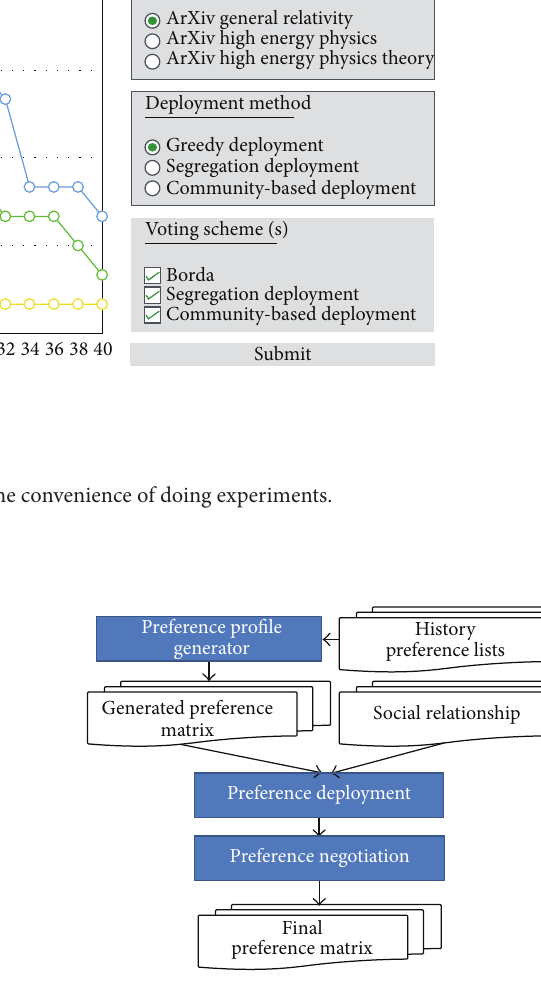
Figure 4: The flow chart of the proposed